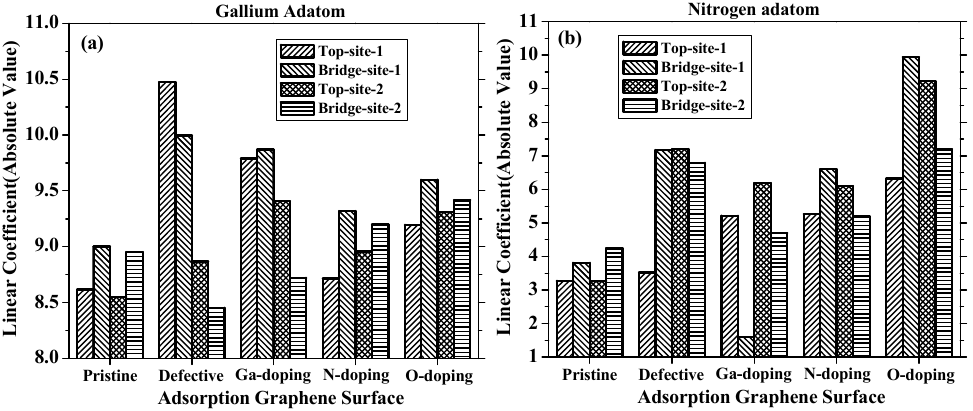
Figure 7. Absolute value of linear coefficient characterizing the relationship between the adsorption energies and strains for ( a ) gallium adatom and ( b ) nitrogen adatom.